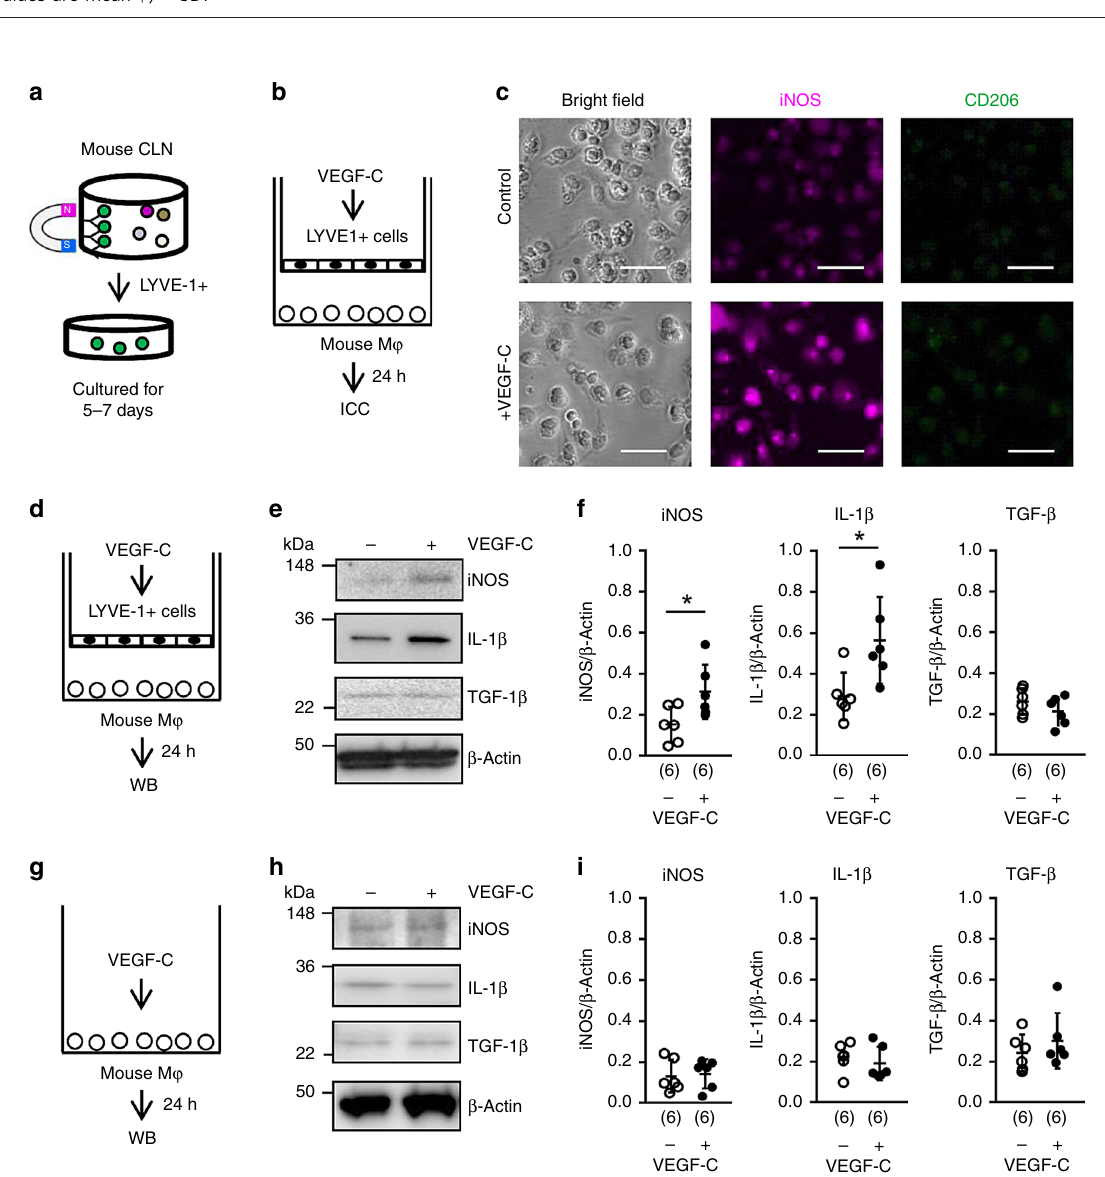
Fig. 4 Cervical lymphatic in fl ammation through VEGFR3 tyrosine kinase in mice after stroke: a Male C57BL6 mice were subjected to transient focal ischemia and, immediately after reperfusion the vehicle (PBS 10 µ L) or MAZ51 (3 ng/10 µ L) were injected into the nasal cavity. b MAZ51 treatment suppressed tyrosine phosphorylation in super fi cial CLN lymphatic endothelium at 72 h after focal ischemia (Sham; n = 4, MCAO; n = 9, MCAO + MAZ51; n =